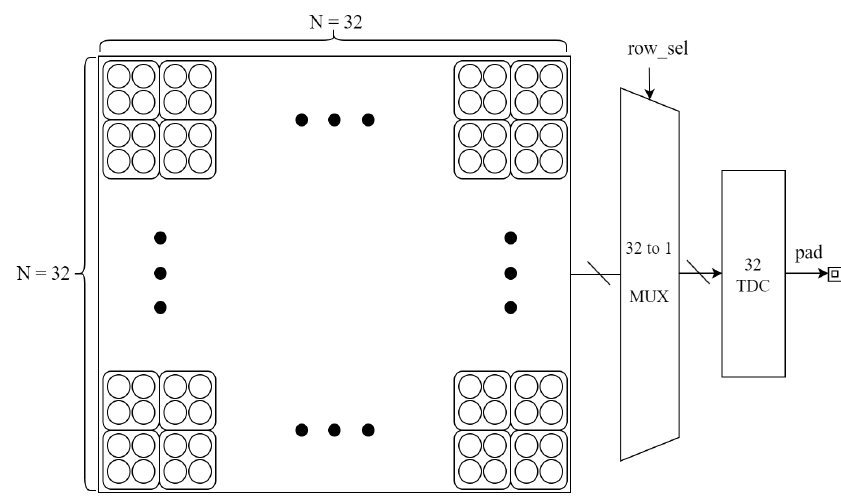
Figure 4. The block diagram of the tested chip with 32 line-shared TDCs and 32 × 32 macro SPAD arrays combined by 4 × 4 pixels.